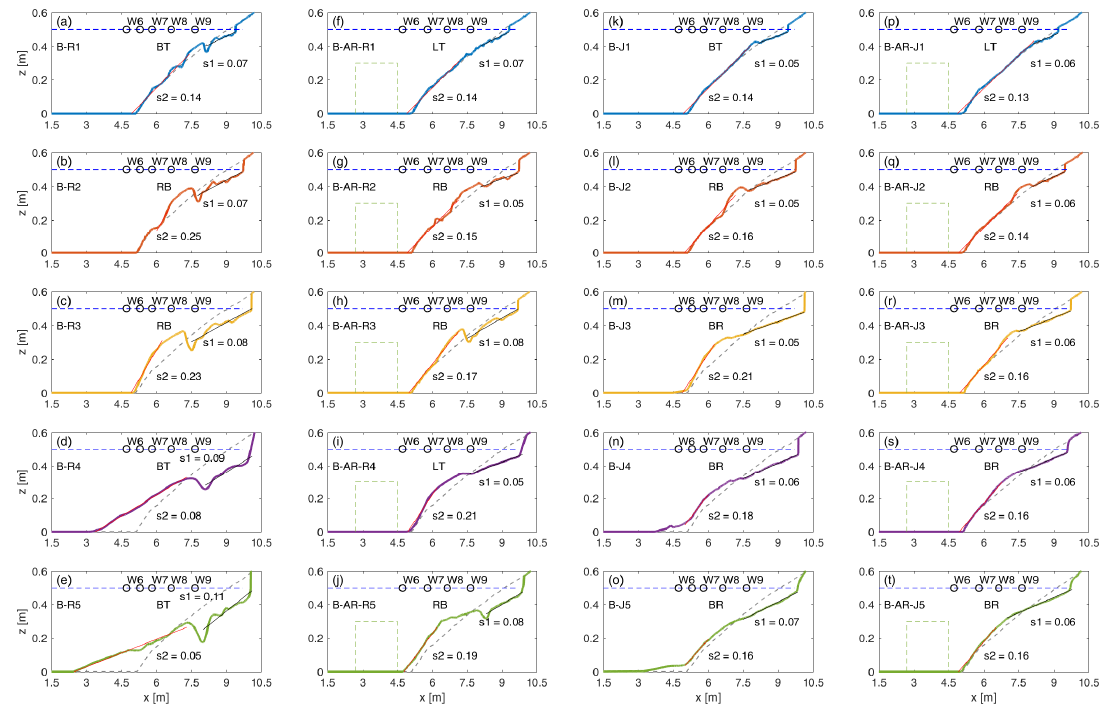
Figure 13. Observed beach state in: ( a – e ) B tests in regular waves; ( f – j ) B-AR tests in regular waves; ( k – o ) B tests in irregular waves; ( p – t ) B-AR tests in irregular waves ( s = tan β means the beach slope).